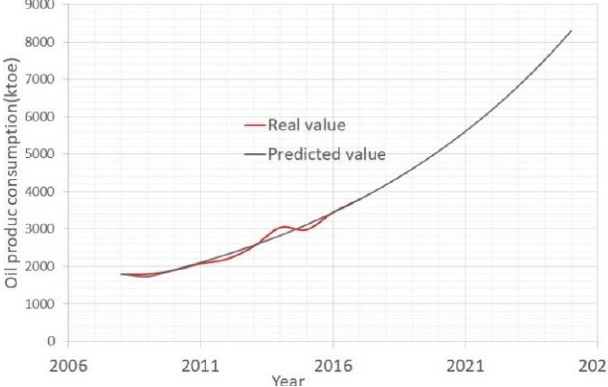
Fig. 2. Ethiopian oil products energy consumption forecast